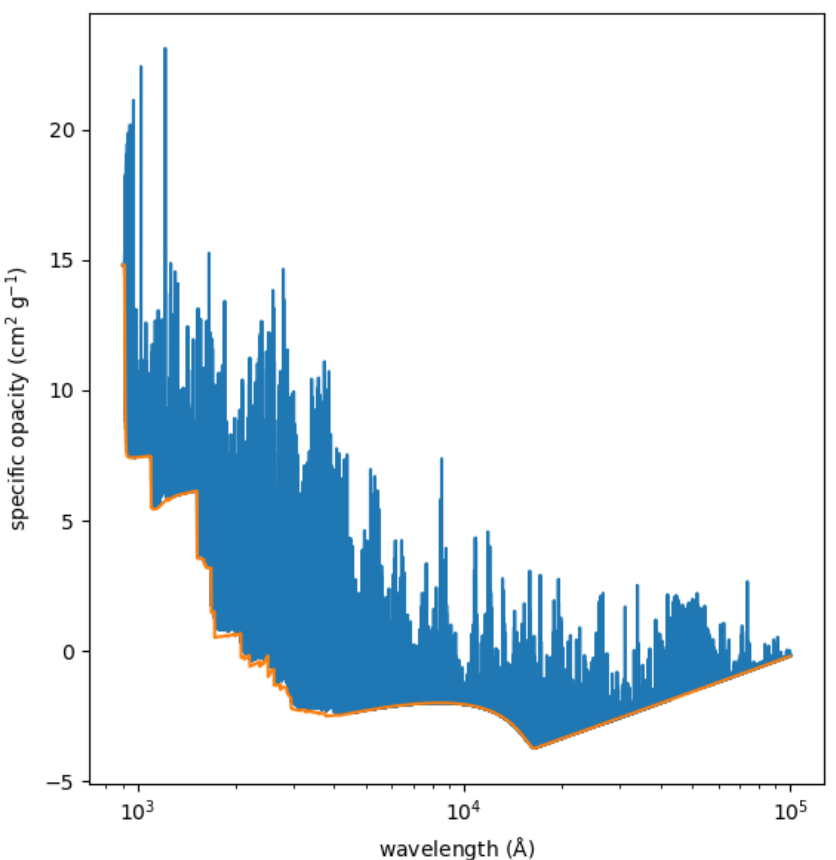
Figure 1. ( Upper panel ) Relationship between temperature and density in the atmosphere of a solar-like star ( T eff = 5777 K, log g = 4.437 with g in cm s − 2 , and the chemical abundances given in [19]) from a plane-parallel model in Local Thermodynamical Equilibrium. The indicated point is just slightly higher than optical depth unity, corresponding to ρ (cid:39) 1.2 × 10 − 7 g cm − 3 and T (cid:39) 5100 K. ( Lower panel ) Continuous (photoionization plus bremsstrahlung; orange) and total opacity for the point in the T- ρ run marked in the top